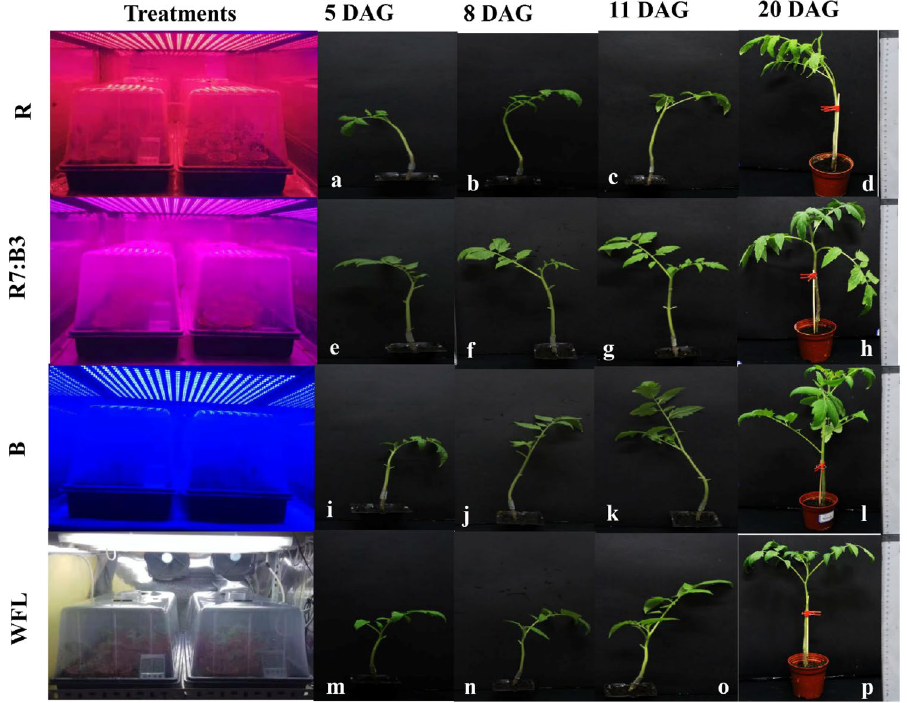
Figure 2. The stages of grafted seedlings in which the SEM examination was performed on the 5th, 8th, 11th and 20th days after grafting (DAG).